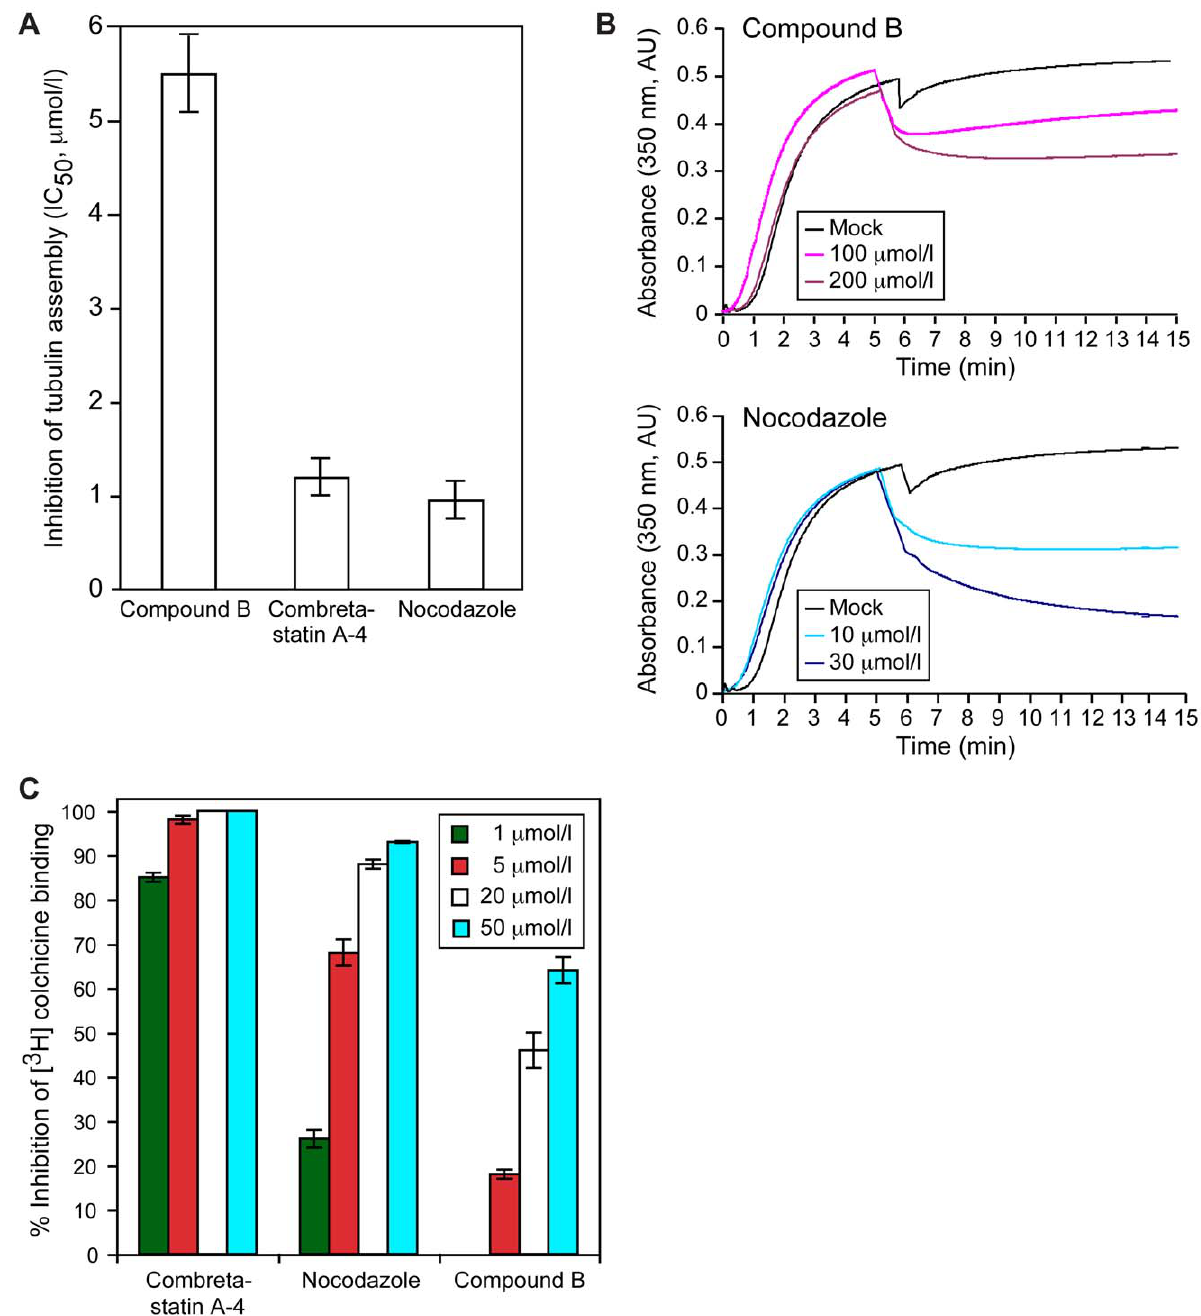
Figure 5. Compound B inhibits tubulin assembly and destabilizes MTs by acting at the tubulin colchicine site. Compound B inhibited tubulin assembly in vitro ; combretastatin A-4 and nocodazole acted as positive controls ( A ). Compound B depolymerized non-stabilized MTs in vitro ; nocodazole acted as the positive control ( B ). Compound B competed with [ 3 H]colchicine for binding to the colchicine site in ab -tubulin. The bars represent standard deviations ( C